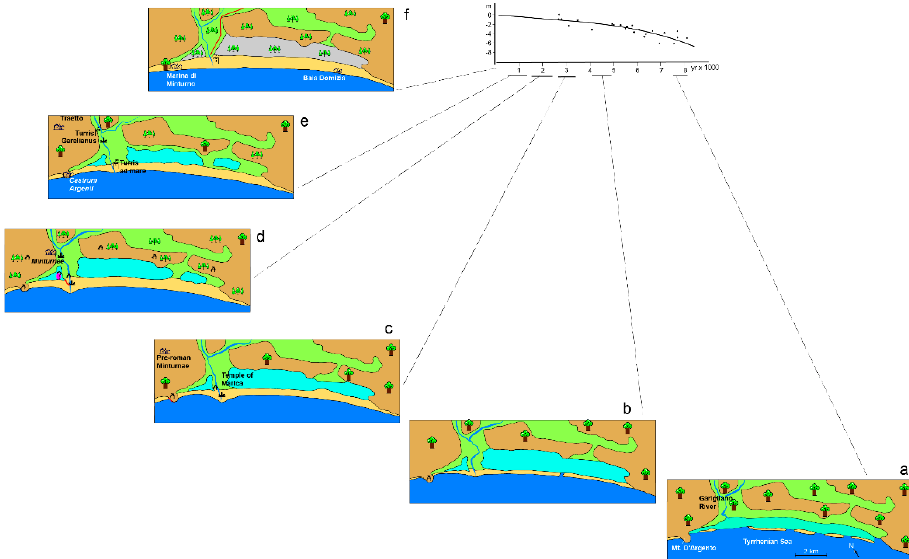
Figure 11. ( a – f ) . Two-dimensional evolutionary schemes of the Campania area inferred from under- ground and historical/archaeological data. The individual images illustrate the coastal landscape relating to the period reported on the abscissa of the sea level rise curve drawn mainly based on 14 C dating of marsh/pond peat levels [36].